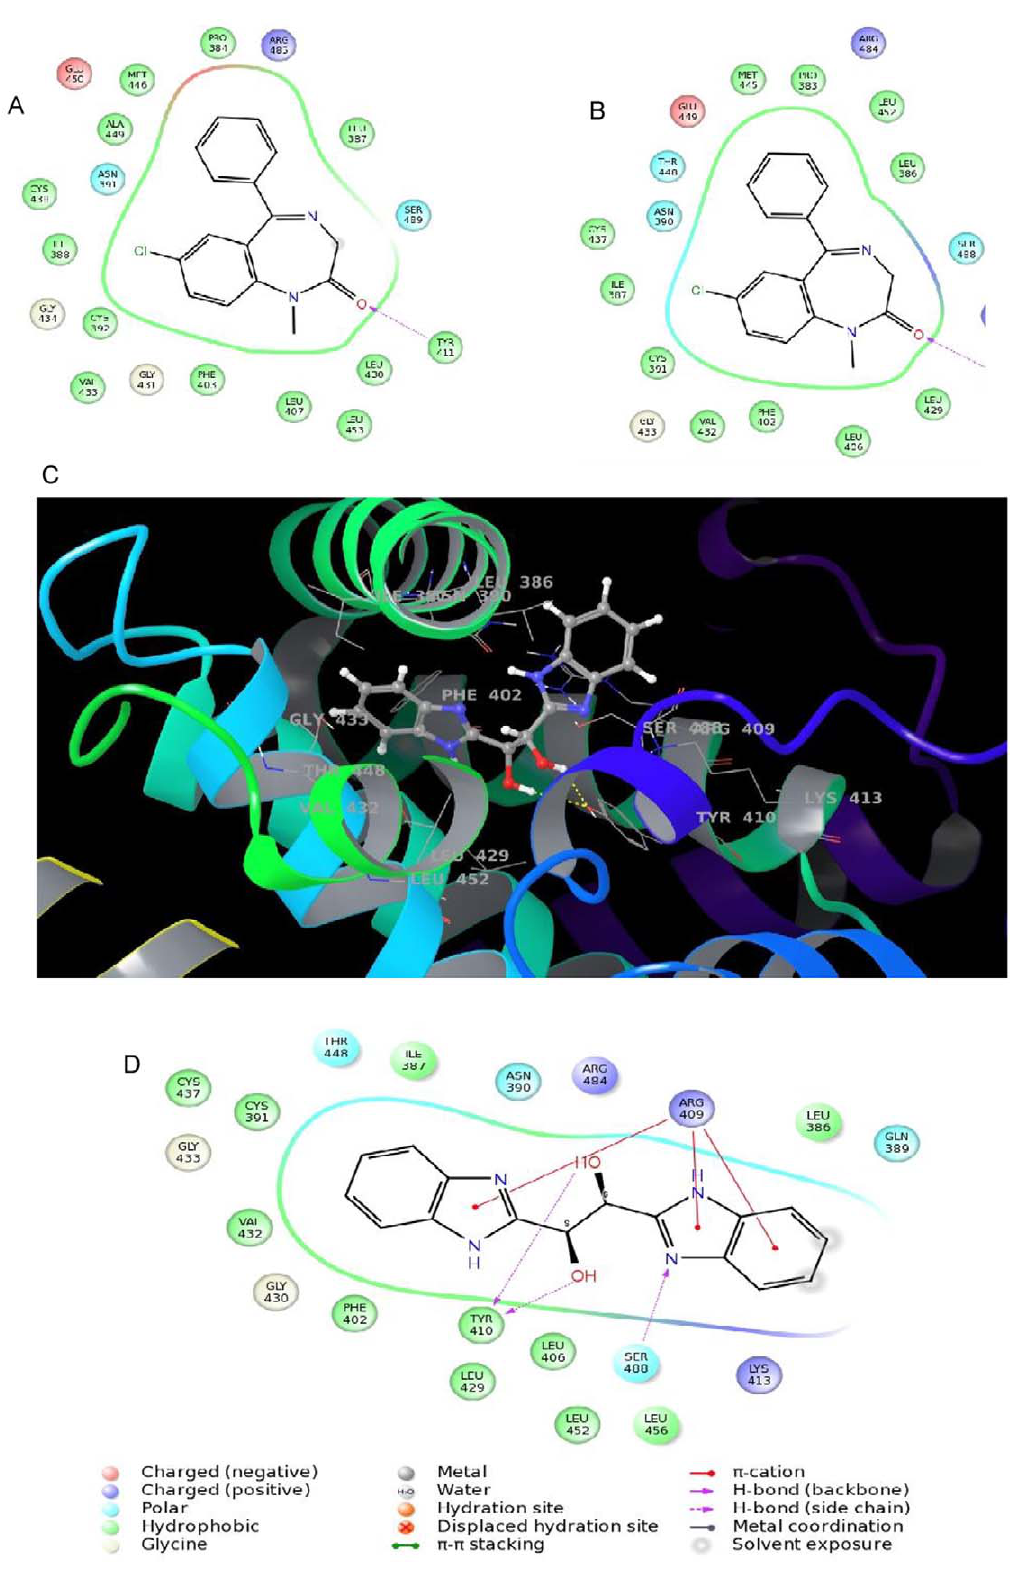
Figure 8. Binding analysis of BBE in the subdomain IIIA of BSA by molecular modeling. 2D ligand interaction diagrams for diazepam with the subdomain IIIA of HSA (A) and BSA (B). 3D interaction diagram for BBE with the subdomain IIIA of BSA (C). 2D BBE interaction diagram with subdomain IIIA of BSA.